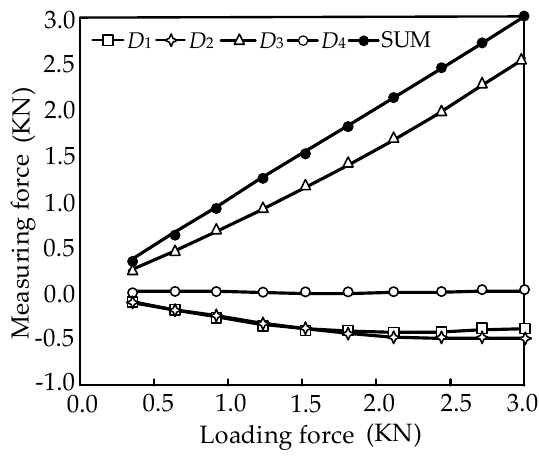
Figure 24. Calibration on the third branch.